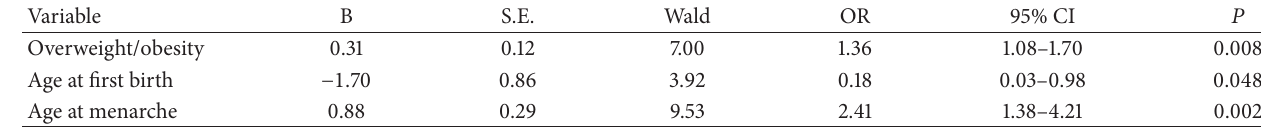
Table 4: Multivariate logistic regression analysis of the associations between various factors and